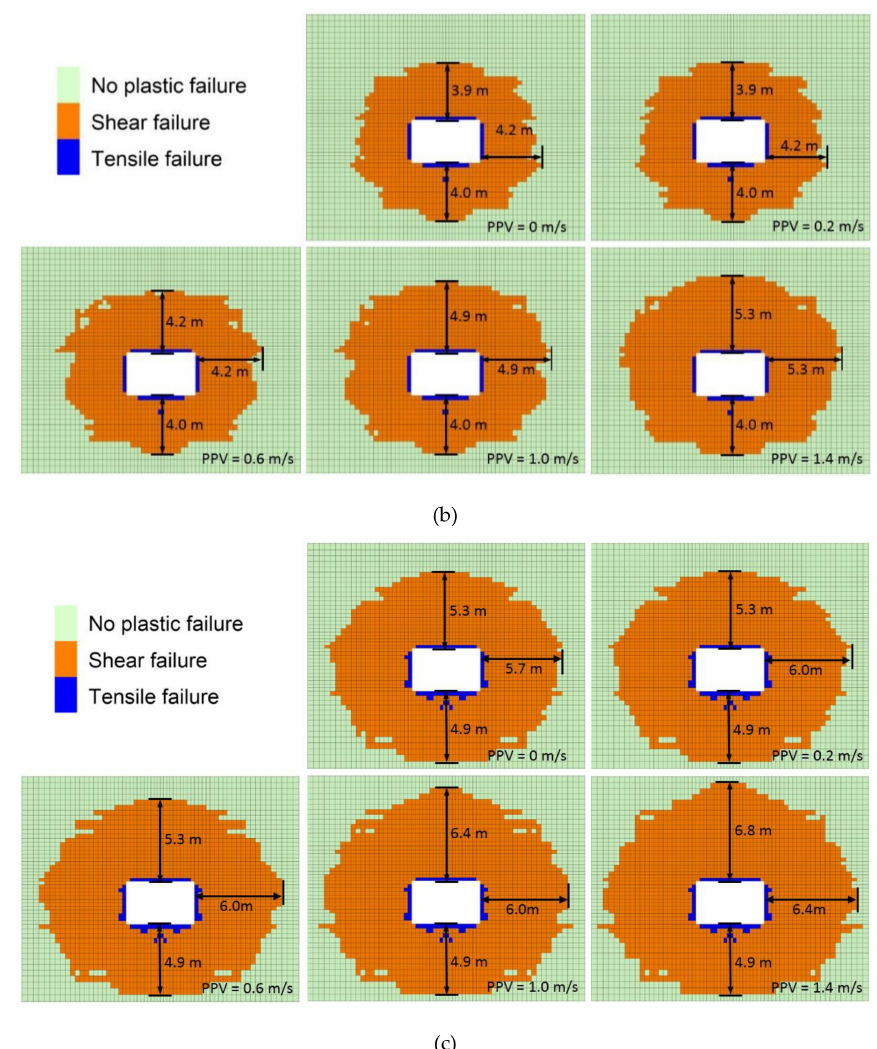
Figure 8. Plastic zone of the roadway under di ff erent superposed dynamic and static loads. ( a ) Plastic zone when the roadway is 400 m deep, ( b ) plastic zone when the roadway is 800 m deep and ( c ) plastic zone when the roadway is 1200 m